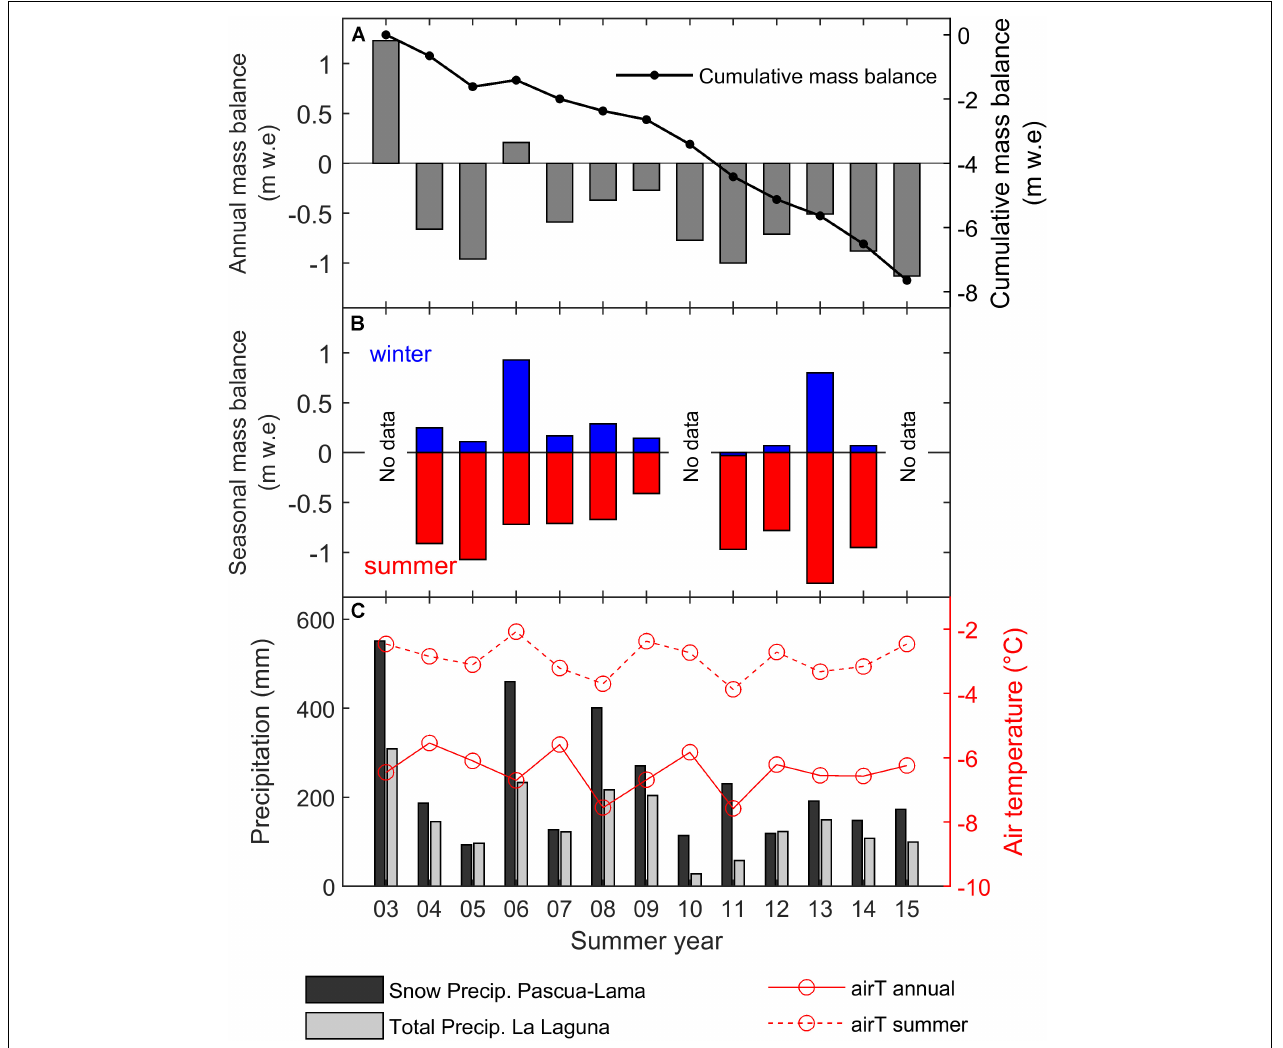
FIGURE 2 | Annual mass balance of Guanaco Glacier. (A) Annual (gray bars) and cumulative (black line) mass balance; (B) winter (blue) and summer (red) mass balance. Only the annual balance (B a ) was measured during the hydrological years 2002–2003, 2009–2010, and 2014–2015. (C) Annual precipitation (bars) at Pascua-Lama camp and La Laguna reference station and air temperature at La Frontera AWS (red lines).